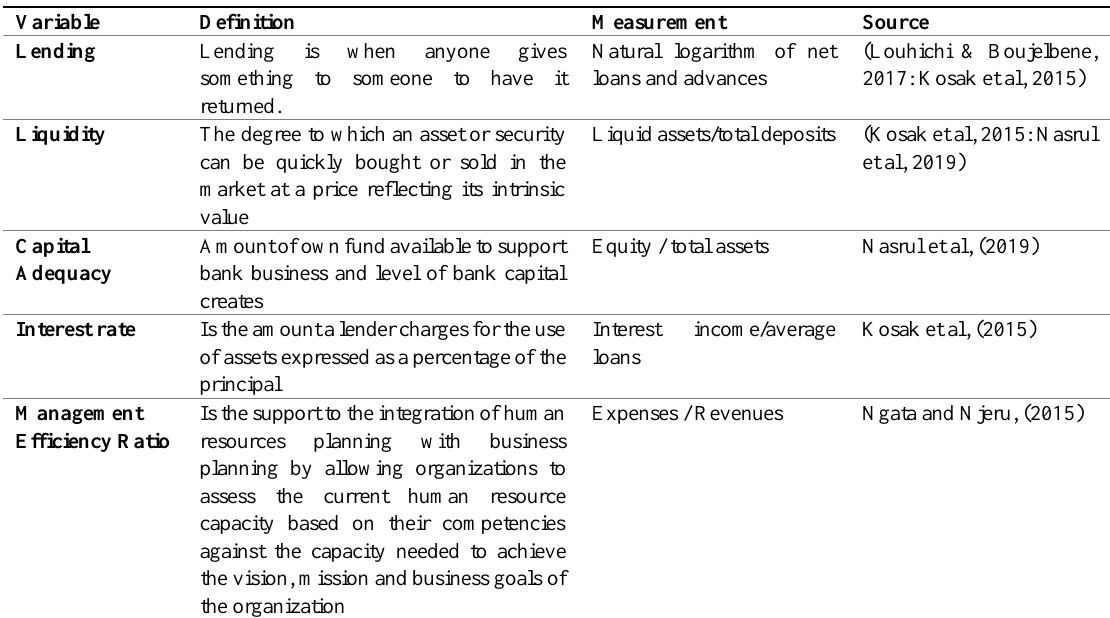
Table 1: Definition and Measurement of